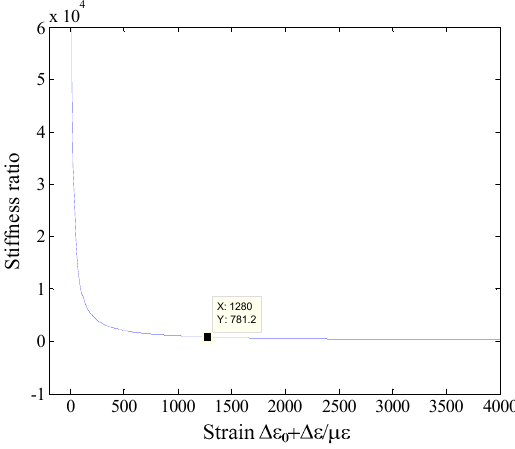
Figure 2. The stiffness ratio versus Δ ε 0 + ε 0 .